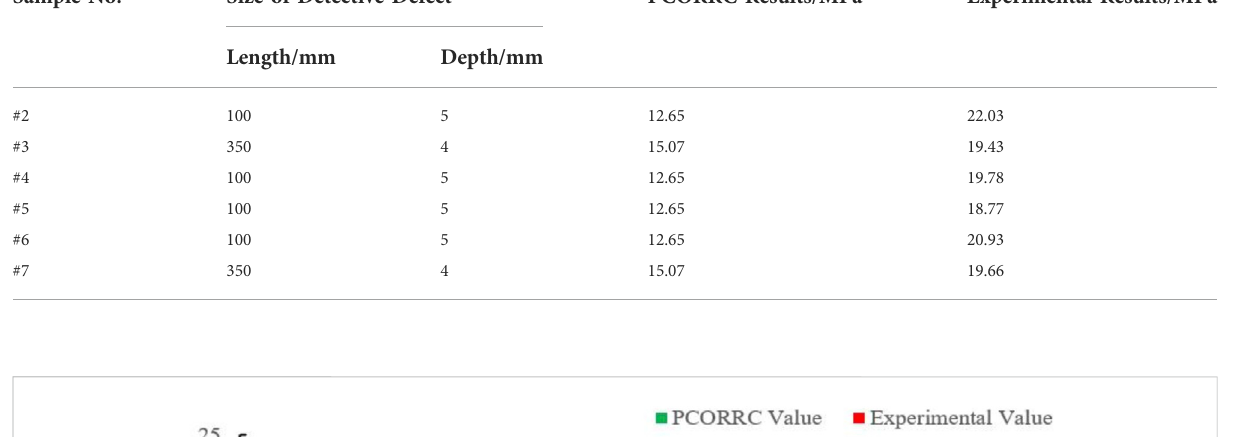
TABLE 6 PCORRC and Experimental results of six pipe samples. Sample No.